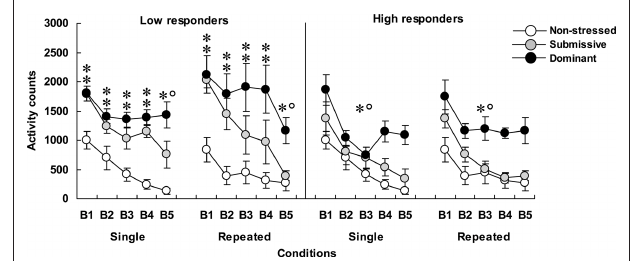
Figure 1 | Home-cage motor activity over 15-min blocks of time (B1 to B5) in non-stressed mice as well as in submissive and dominant mice that had experienced single or repeated aggressive encounters. Data for low corticosterone responders are shown in the left panel and that of high responders are depicted in the right panel. An N of 10 and 9 comprised the non-stressed mice that were handled on single or repeated occasions, respectively. Among mice that were submissive in an aggressive encounter, four were low corticosterone responders and five were high responders in both the single and repeated conditions. Among dominant animals, five and four mice were represented in the low and high responders after a single aggressive encounter, whereas six and three mice were low and high responders in the repeated condition, respectively. Data represents means ± SEM. * p < 0.05 relative to non-stressed mice. * ° p < 0.05 relative to non-stressed and submissive mice.